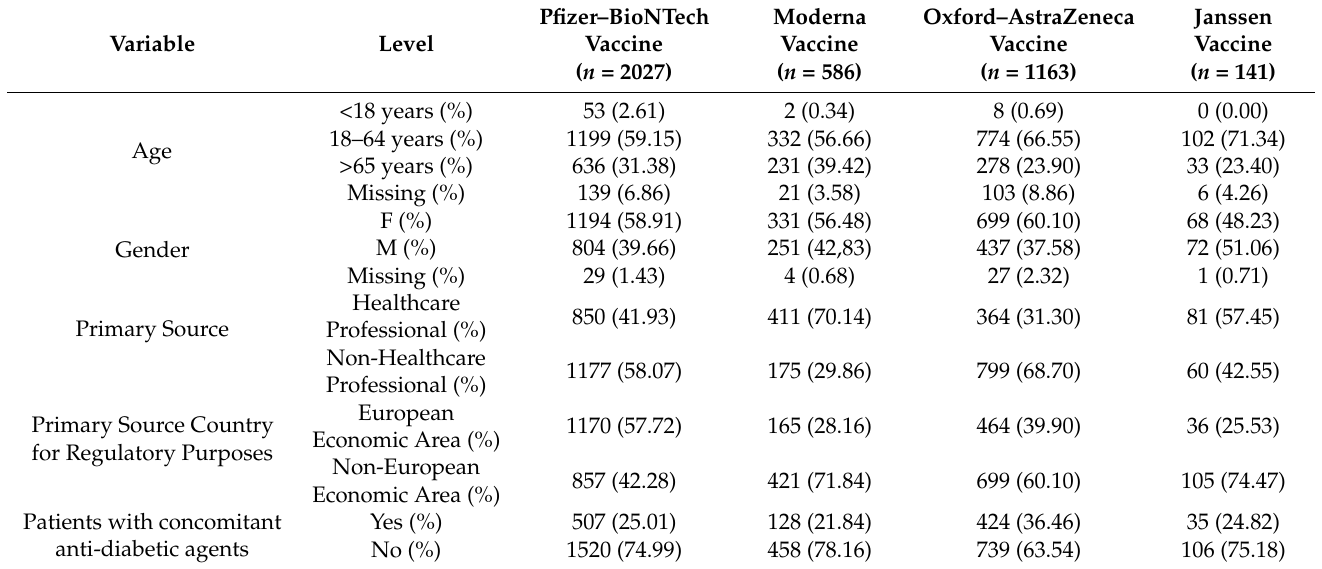
Table 2. Distribution for age, gender, primary source, primary source country, presence of concomi- tant anti-diabetic agents among Individual Case Safety Reports (ICSRs) reporting at least one event of impaired glucose metabolism and having Pfizer–BioNTech, Moderna, Oxford–AstraZeneca, or Janssen Vaccine as suspected vaccine among those reported in Eudravigilance from 1 January 2021